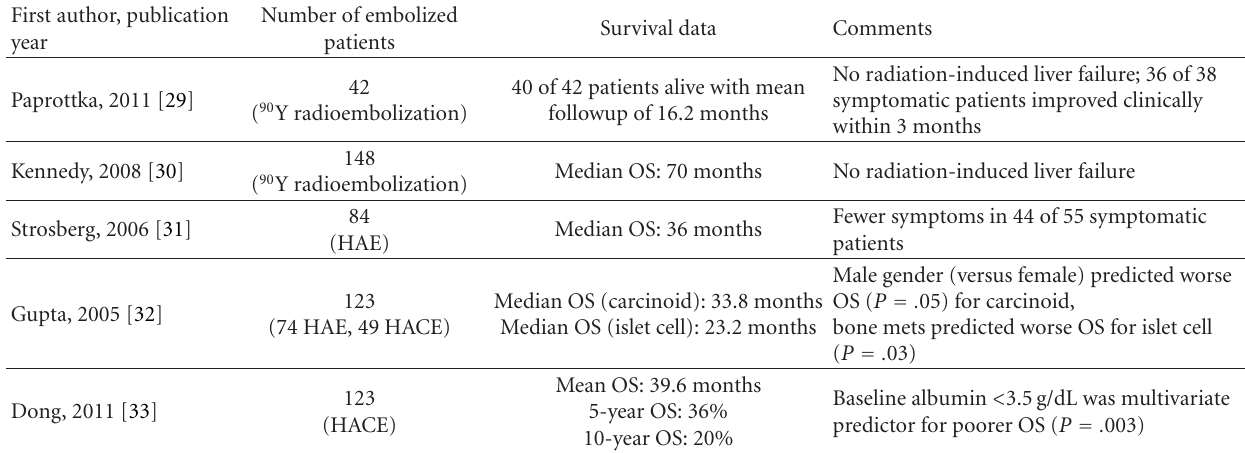
Table 3: Summary of outcomes for intra-arterial therapy of neuroendocrine liver